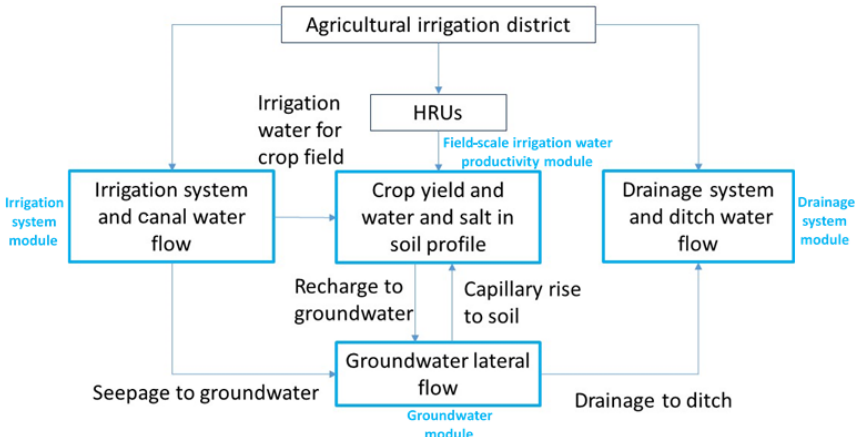
Figure 1. Schematic diagram of the conceptual RIWP model and the coupling between its